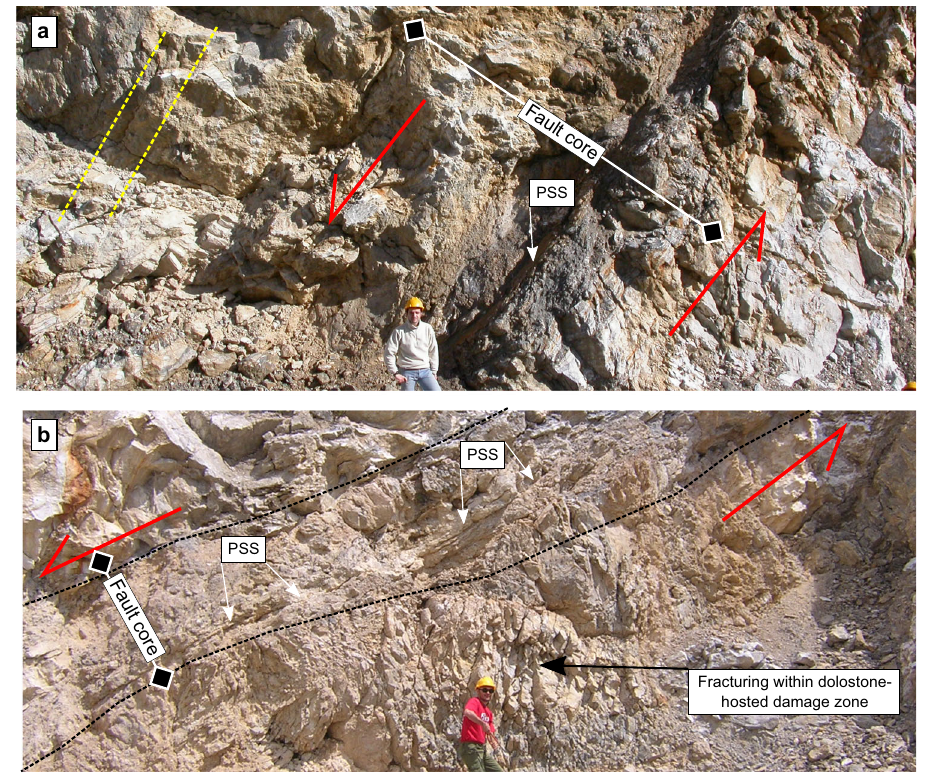
surfaces, PSS. The dashed yellow line marks the fault parallel foliation within the gypsum-anhydrites rocks.